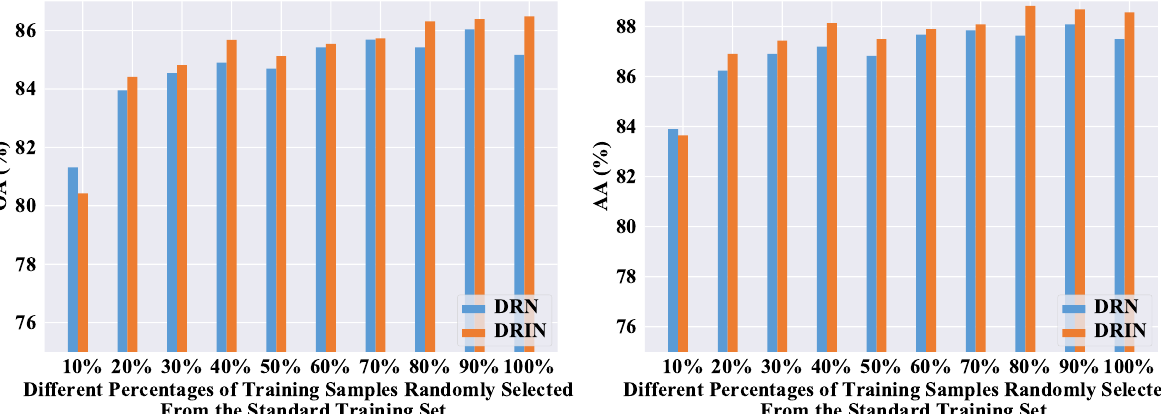
Figure 17. Classification accuracies of the proposed DRIN and its convolution-based counterpart DRN with different training data percentages on the UH